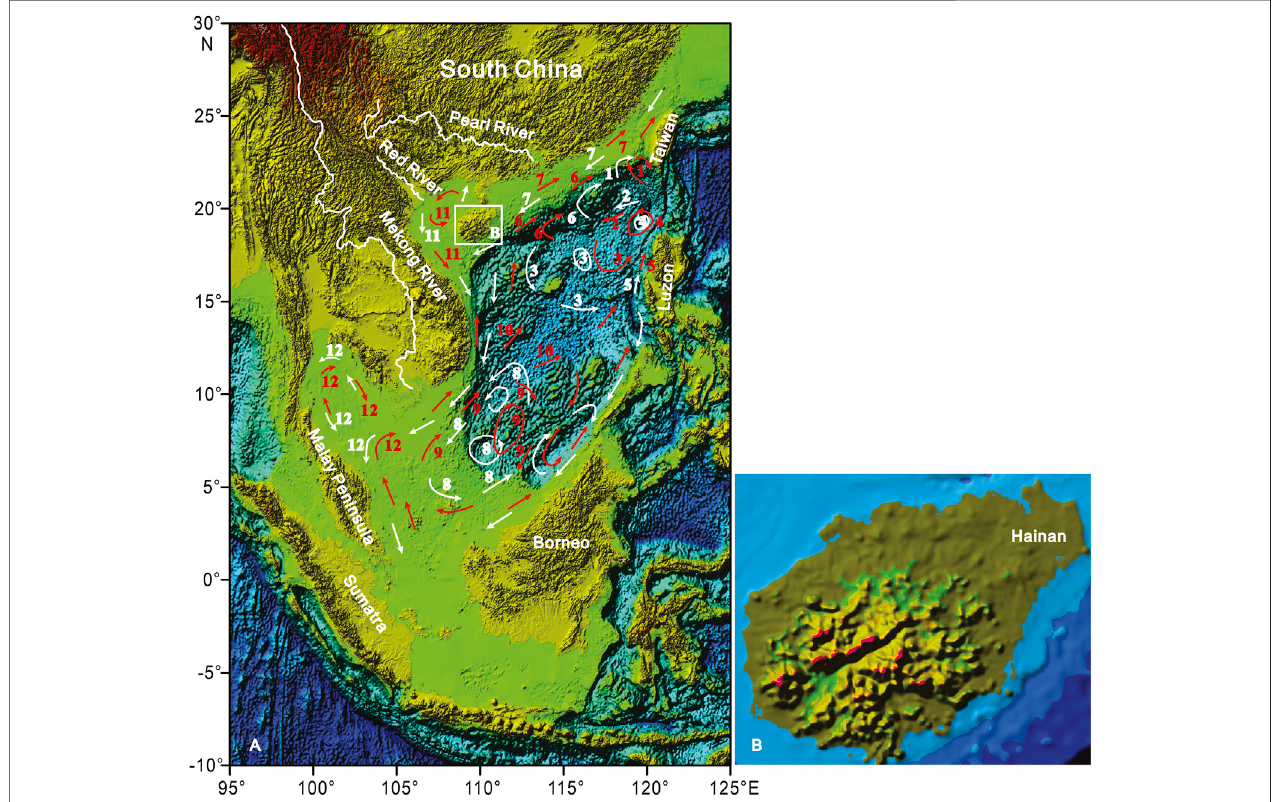
FIGURE1| (A) Location map ofthe Hainan Island and thesurface currents in theSouth China Sea. (B) Topographicmap oftheHainanIsland. Numbers forwinter (white) and summer (red) surface currents: 1, loop current; 2, SCS branch of Kuroshio; 3, NW Luzon Cyclonic Gyre; 4, NW Luzon Cyclonic Eddy; 5, NW Luzon Coastal Current; 6, SCS Warm Current; 7, Guangdong Coastal Current; 8, SCS Southern Cyclonic Gyre; 9, SCS Southern Anticyclonic Gyre; 10, SE Vietnam Offshore Current; 11, Gulf of Tonkin Surface Current; 12, Gulf of Thailand Surface Current. Major surface currents after Liu et al. (2016).